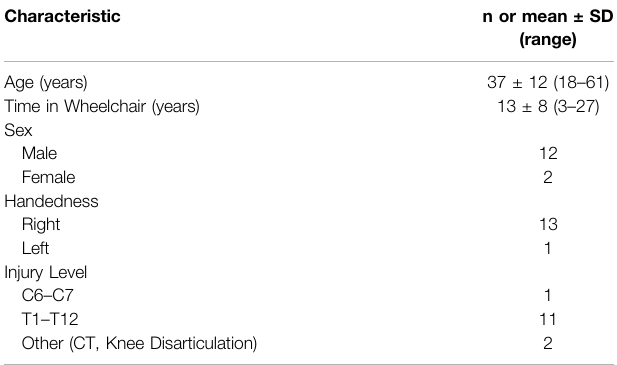
TABLE 1 | Characteristics of included participants (N = 14).